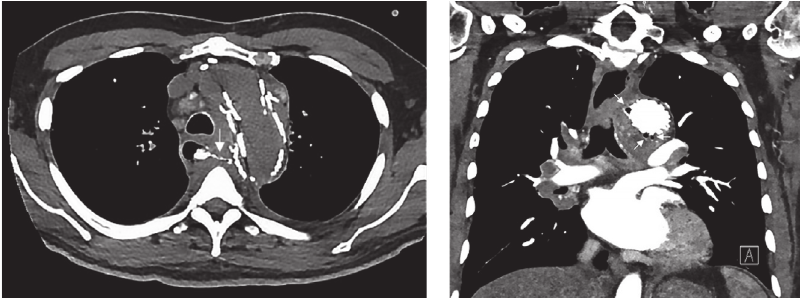
Figure 4: CT angiography axial view showing linear high-density contrast collection extending from esophageal wall towards the aortic graft representing retained barium contrast from the patient’s recent upper gastrointestinal series visualizing fistulous tract and the coronal view showing multiple foci of gas or air bubbles adjacent to the patient’s aortic stent graft.